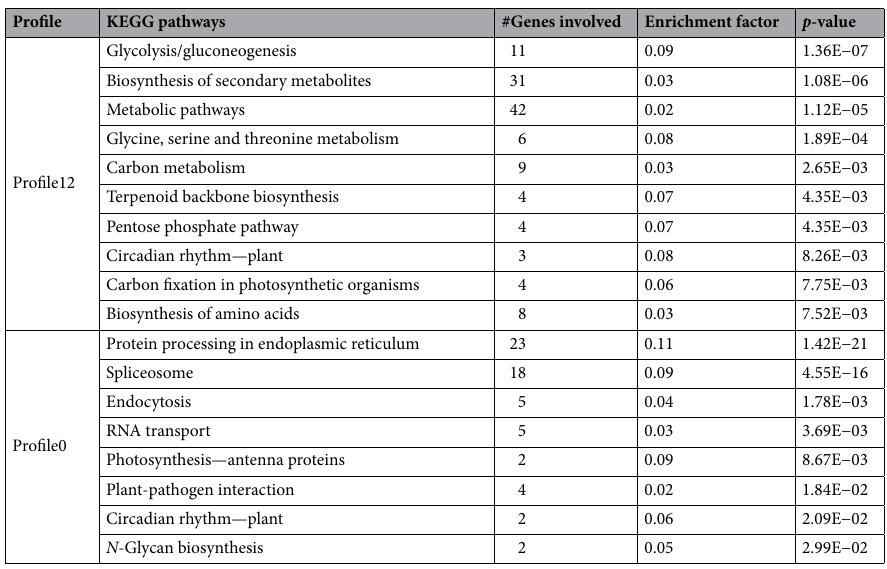
Table 1. The 7 significant expression profiles and their top 10 most significantly enriched functional